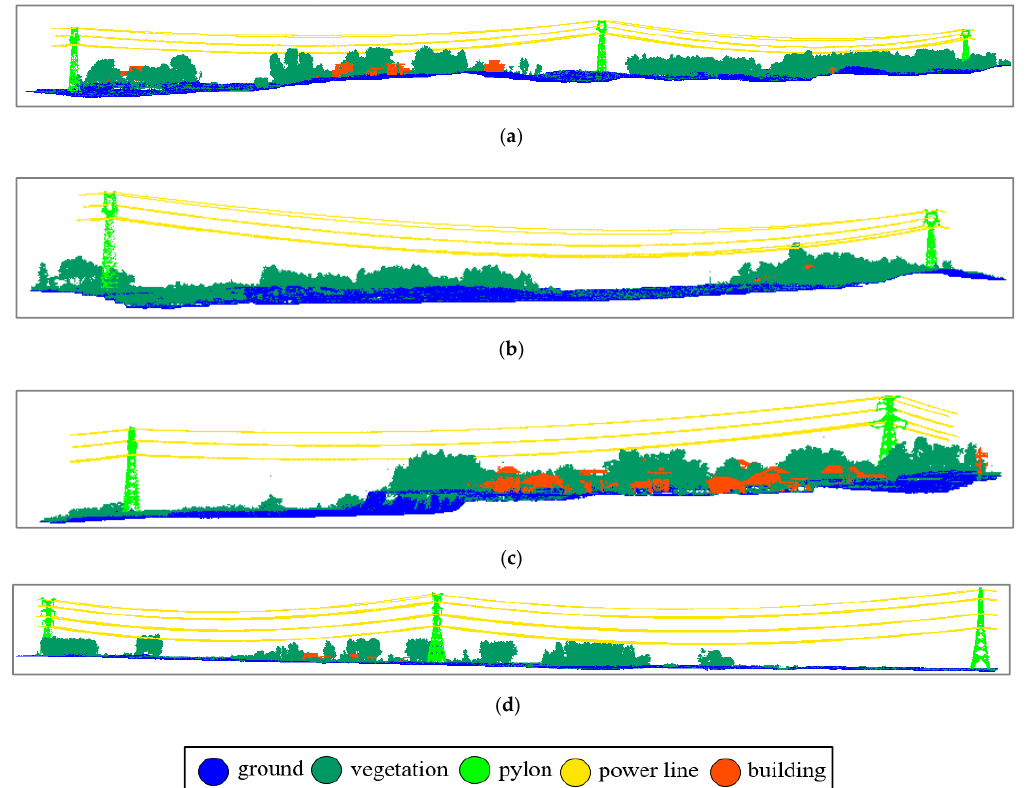
Figure 1. Airborne laser scanning system (ALS) datasets (the colors are rendered according to the true labels): ( a ) Training set; ( b ) site I of the test set; ( c ) site II of the test set; ( d ) site III of the test set.